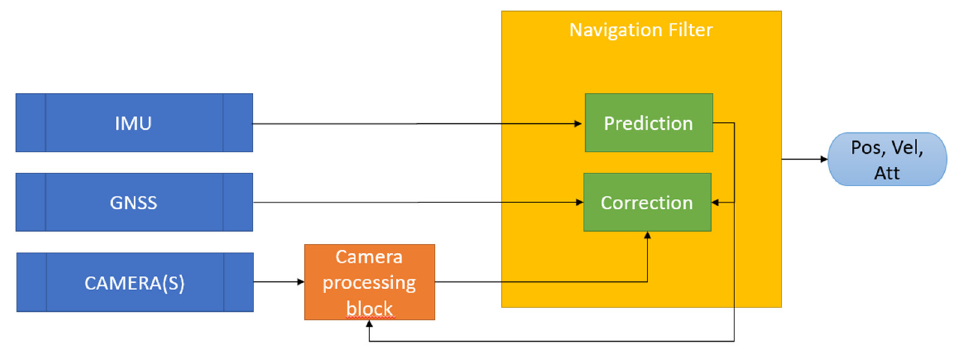
Figure 3. Scheme of the multi-sensor